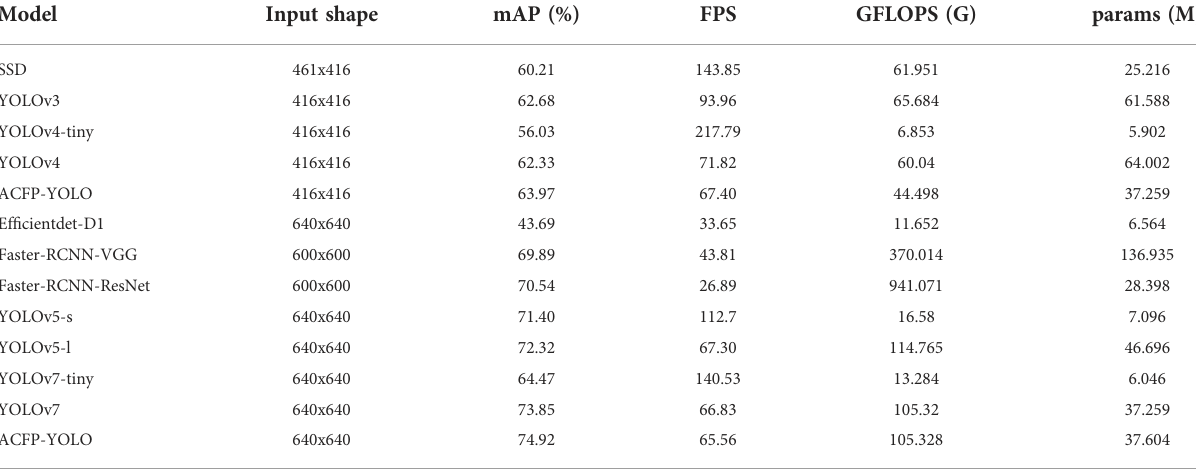
TABLE 5 Performance Index Values of Mainstream Object Detection Algorithms on Underwater Garbage Detection Datasets. Model